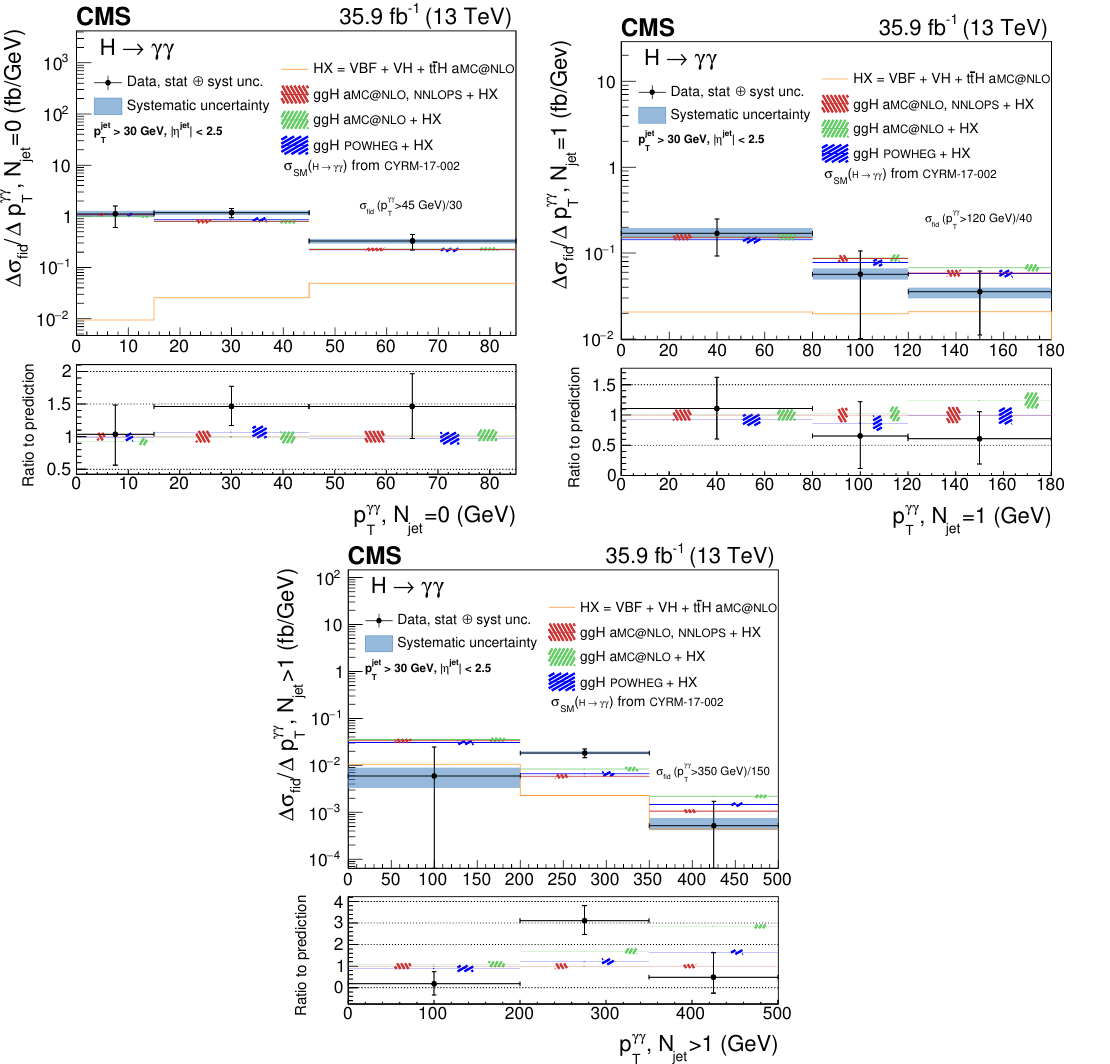
Figure 9 . Measurement of the di(cid:11)erential cross section (black points) as function of p (cid:13)(cid:13) N jet simultaneously. The error bars indicate 1 standard deviation uncertainty. The systematic component of the uncertainty is shown by the blue band. The measurements are compared to di(cid:11)erent simulation programs (histograms) with their uncertainties (hatched areas), all normalized to the same theoretical predictions from ref. [13]. The normalization of the cross section in last, over(cid:13)ow bin is indicated in the (cid:12)gure.